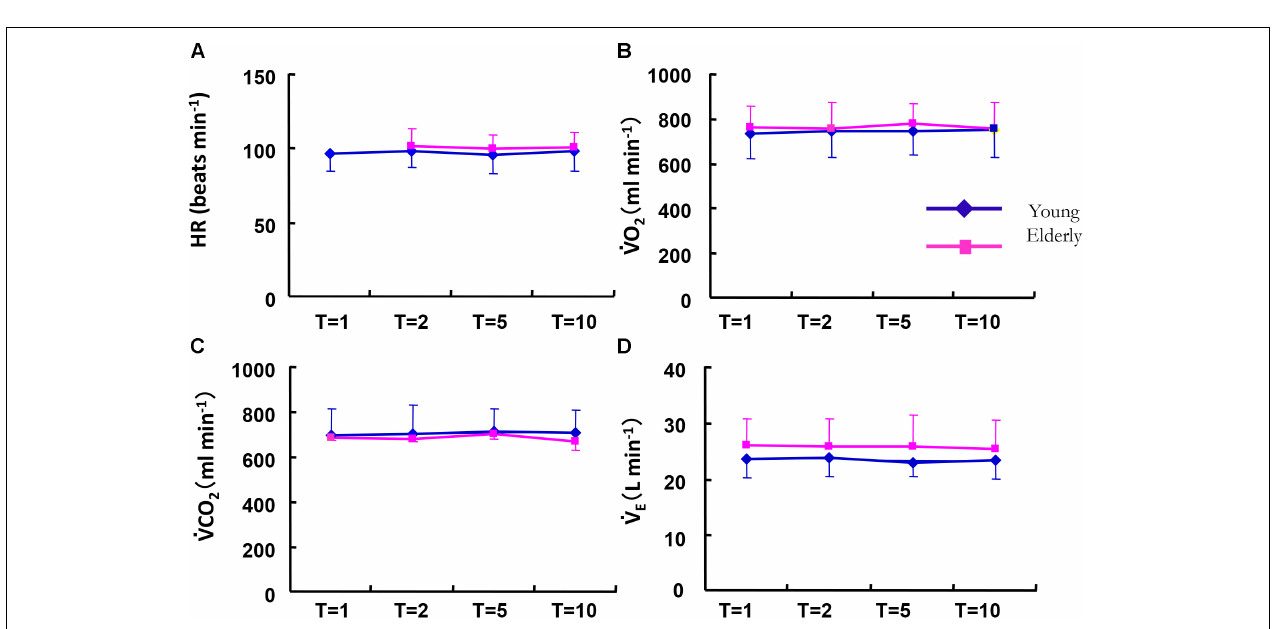
FIGURE 3 | Comparison of the amplitude ( Amp ) ratio ( A ratio for each variable between the constant and sinusoidal load intensity variation) and the phase shift ( PS ) of the HR (A,E) , ˙VO 2 (B,F) , ˙VCO 2 (C,G) , and ˙V E (D,H) , between the elderly individuals ( red line ) and the younger individuals ( blue line ) as a function of the periods of sinusoidal changes in treadmill speed. Data are mean ± SD. ∗ p < 0.05, ∗∗ p < 0.01 vs. ELD.